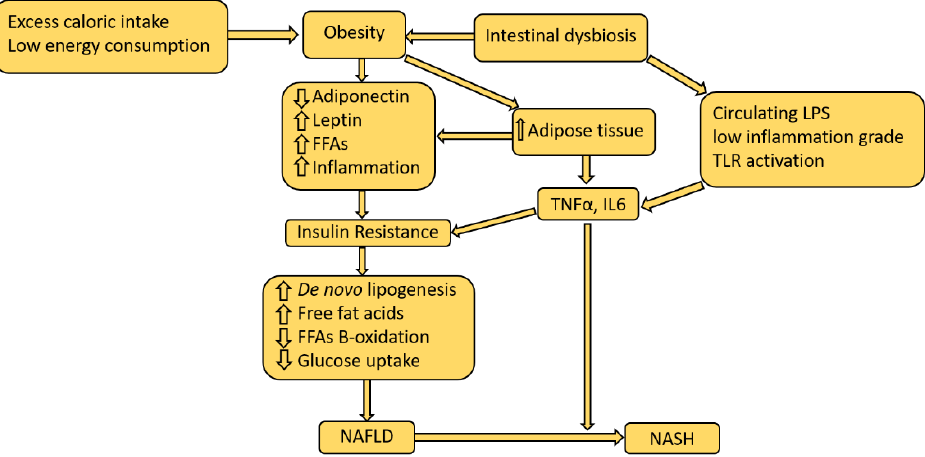
Figure 1. Schematic representation of the pathophysiological mechanisms of Non-Alcoholic Fatty Liver Disease (NAFLD) development. LPS: lipopolysaccharides; TNF-α: tumor necrosis factor-alpha; IL-6: interleukine-6; TLR: toll-like receptor; FFAs: free fatty acids.